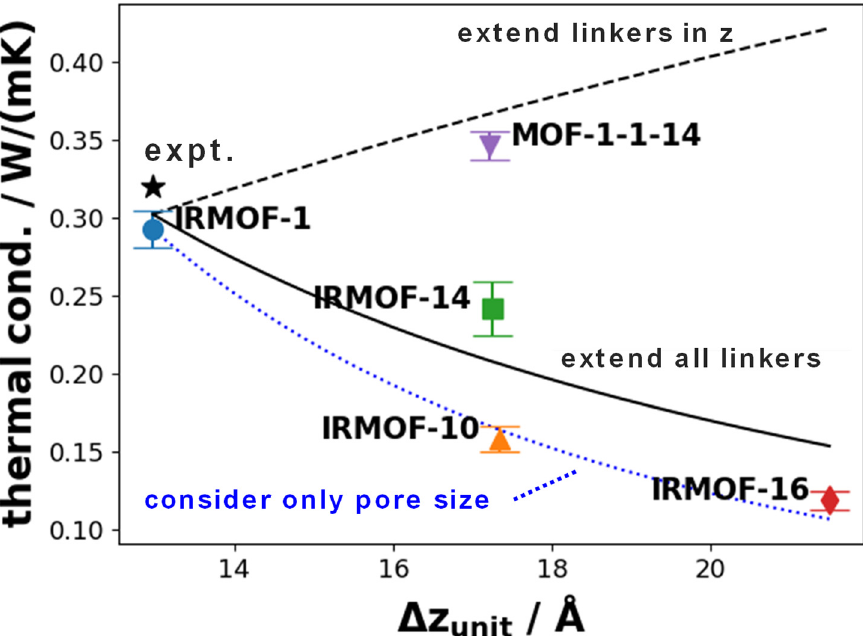
Figure 4. Thermal conductivities of the investigated MOFs obtained by NEMD simulations as a function of the length of the thermal repeat unit ∆ z unit , which is equal to half of a conventional cubic unit cell (see Section 3 for details). The error bars reflect the uncertainty of the infinite size extrapolation (for details see Supplementary Materials Section S3.3). For IRMOF-1, the experimental value [21] at room temperature is indicated as a black star. The lines describe certain approximate predictions described in detail in the main text. They reflect the expected situation for simultaneously extending all linkers (solid black line), for extending the linkers only in the heat transport direction (dashed black line) and for solely considering the increase of the pore size, disregarding the atomistic structure of the MOF (dotted blue line). These predictions are based on the transport-channel insulances calculated for IRMOF-1. The minor deviation of the resulting model value for IRMOF-1 from the direct NEMD result for κ is a consequence of the statistical errors encountered when determining the individual insulance contributions.